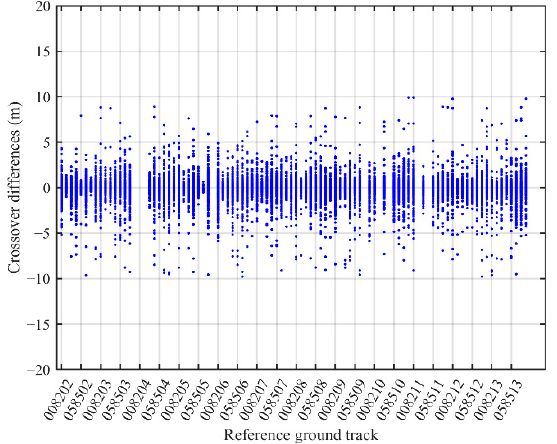
Figure 7. Distribution of crossover differences of each reference ground track, including 6 beams. The horizontal axis scale is a combination of the reference ground track (e.g., 0082) and the repetition cycle (e.g., 02).